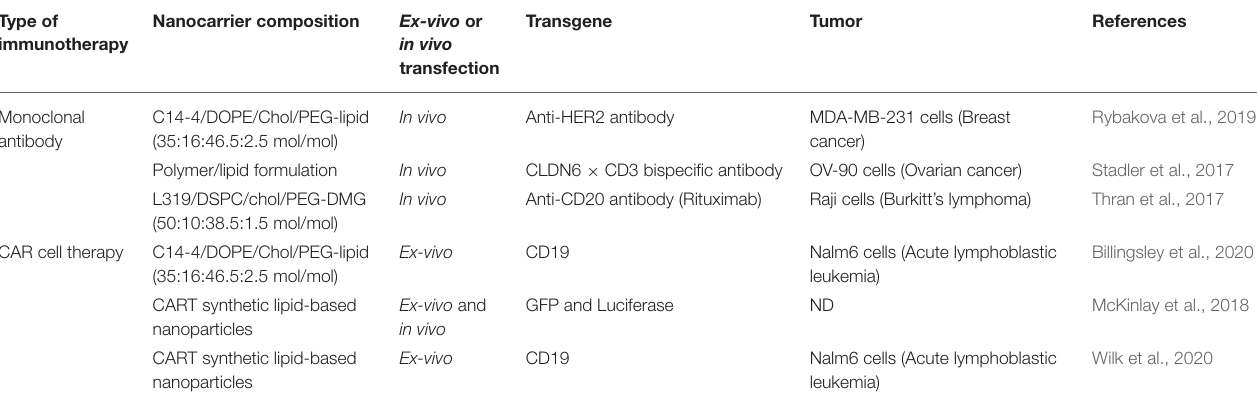
TABLE 2 | Overview of formulated mRNA strategies for monoclonal antibody and CAR cell